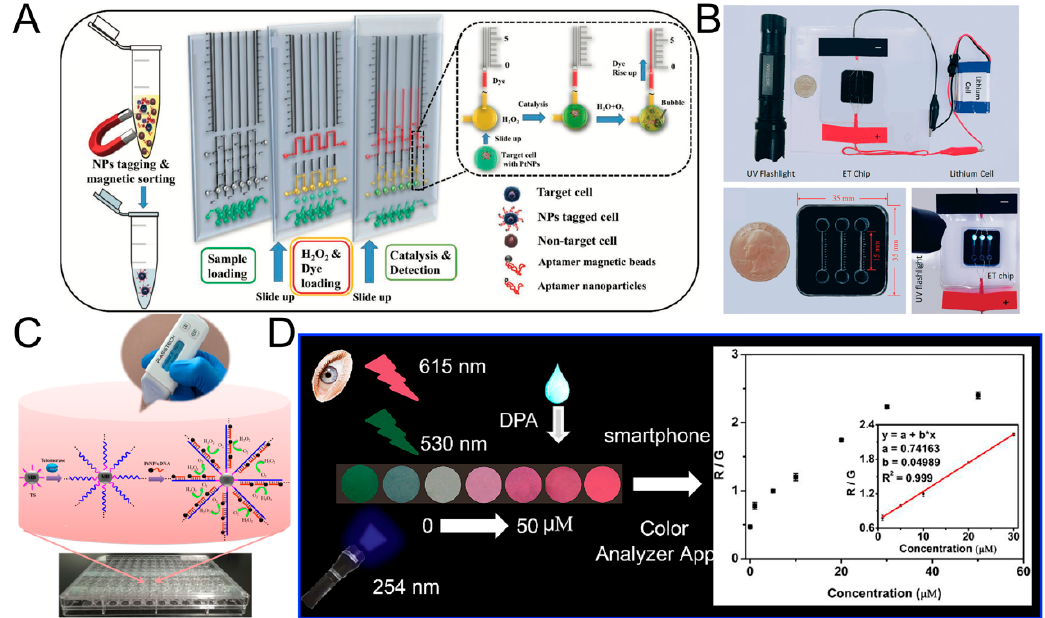
Figure 6. Point-of-Care testing devices. ( A ) Detecting the number of CTC based on distance, by labelling CTC with aptamer-conjugated nanoparticles (ACNP), which has hydrogen peroxide catalytic activity, in the presence of hydrogen peroxide, gas is generated to push the red ink to move, and the distance can be read. Reprinted with permission from ref [133]. Copyright 2019, John Wiley and Sons. ( B ) Quantify the activity of alkaline phosphatase (ALP) by distance. Reprinted with permission from ref [132]. Copyright 2018, Royal Society of Chemistry. ( C ) Use a portable pressure gauge to detect the pressure, to detect the telomerase activity of a single cells. Reprinted with permission from ref [134]. Copyright 2017, American Chemical Society. ( D ) A color-based method to detect anthrax biomarker DPA. Reprinted with permission from ref [131]. Copyright 2020, Elsevier.